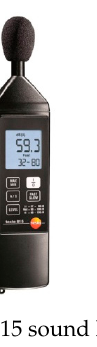
Figure 13. Testo 815 sound level meter.